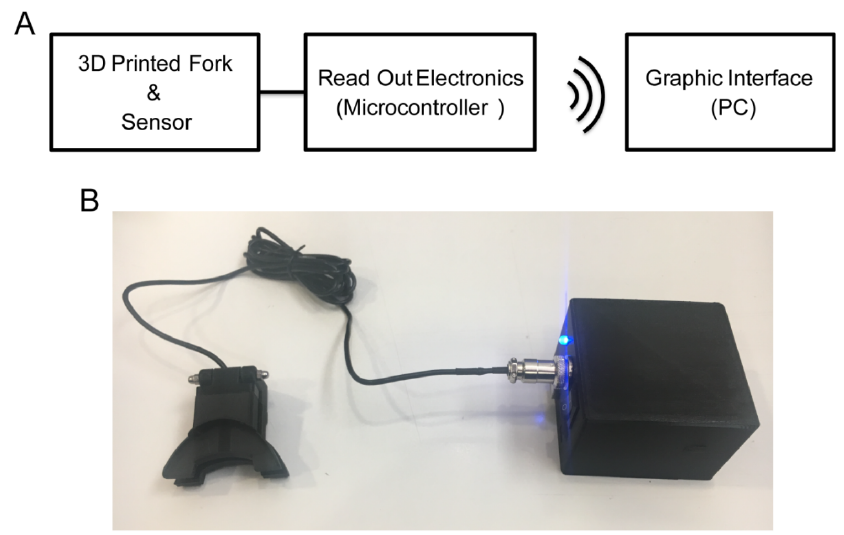
Figure 1. Bite force measurement device. ( A ) Schematic representation of the system: the force sen- sor placed in a 3D printed forks interface is wired connected to the electronic instrumentation, which is wirelessly connected to the PC. ( B ) Developed device: the force sensor with the 3D printed inter- face connected to the electronic instrumentation (box).